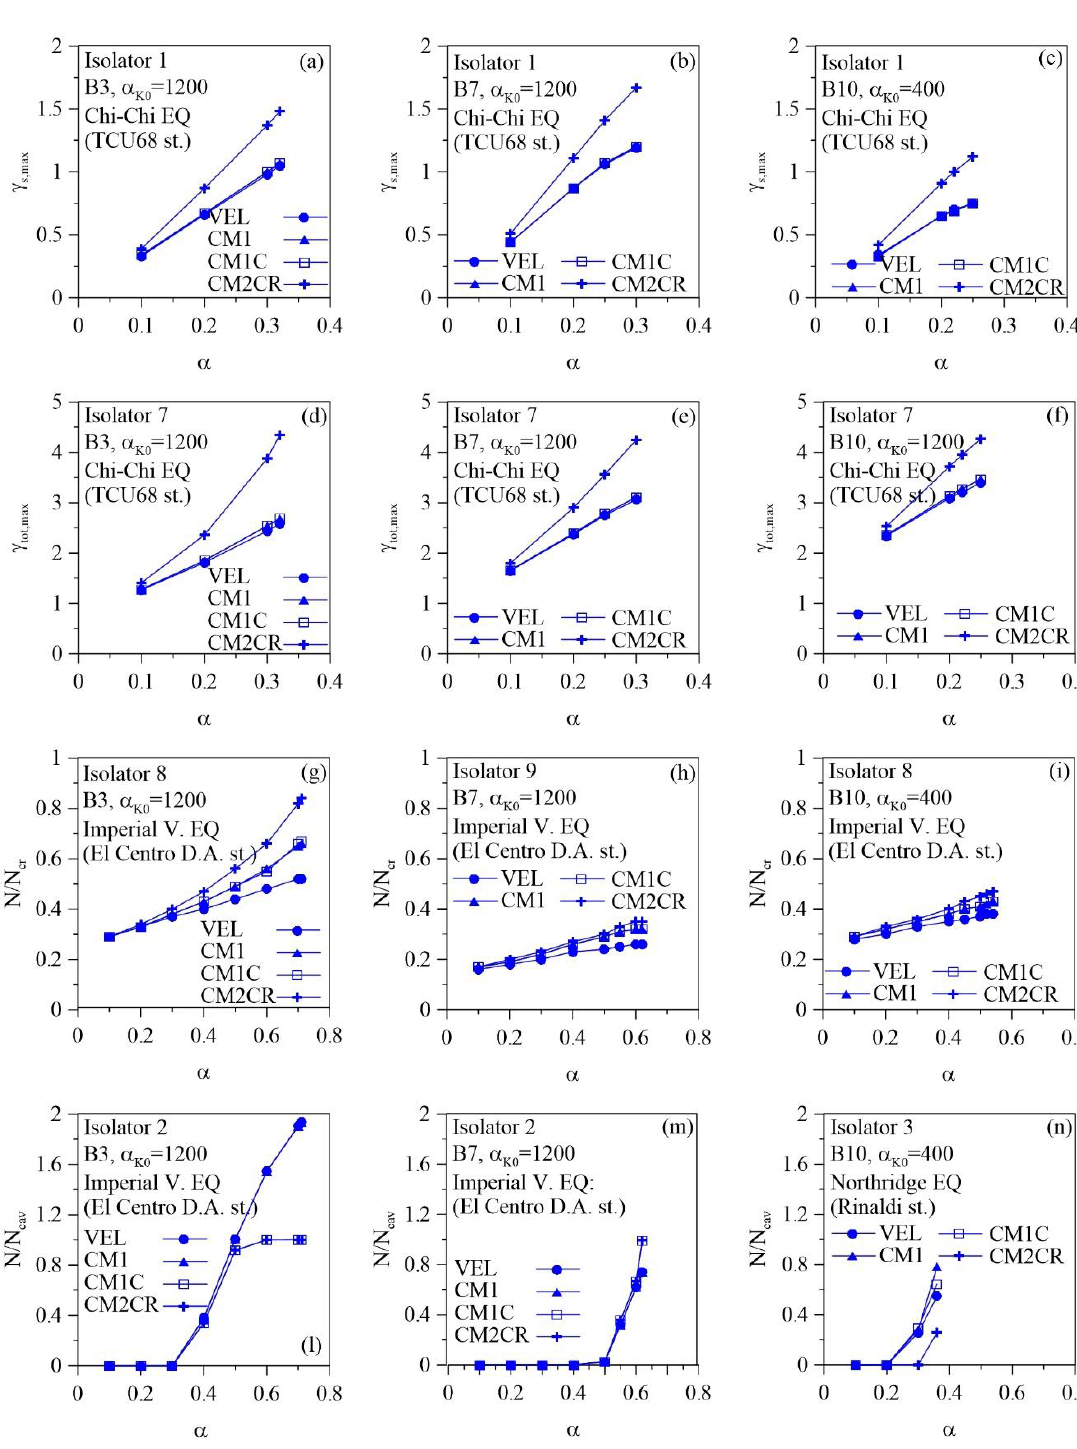
Figure 9. Response parameters of the base-isolation system for the B3 ( a , d , g , l ), B7 ( b , e , h , m ) and B10 ( c , f , i , n ) test structures subjected to the Chi-Chi EQ.